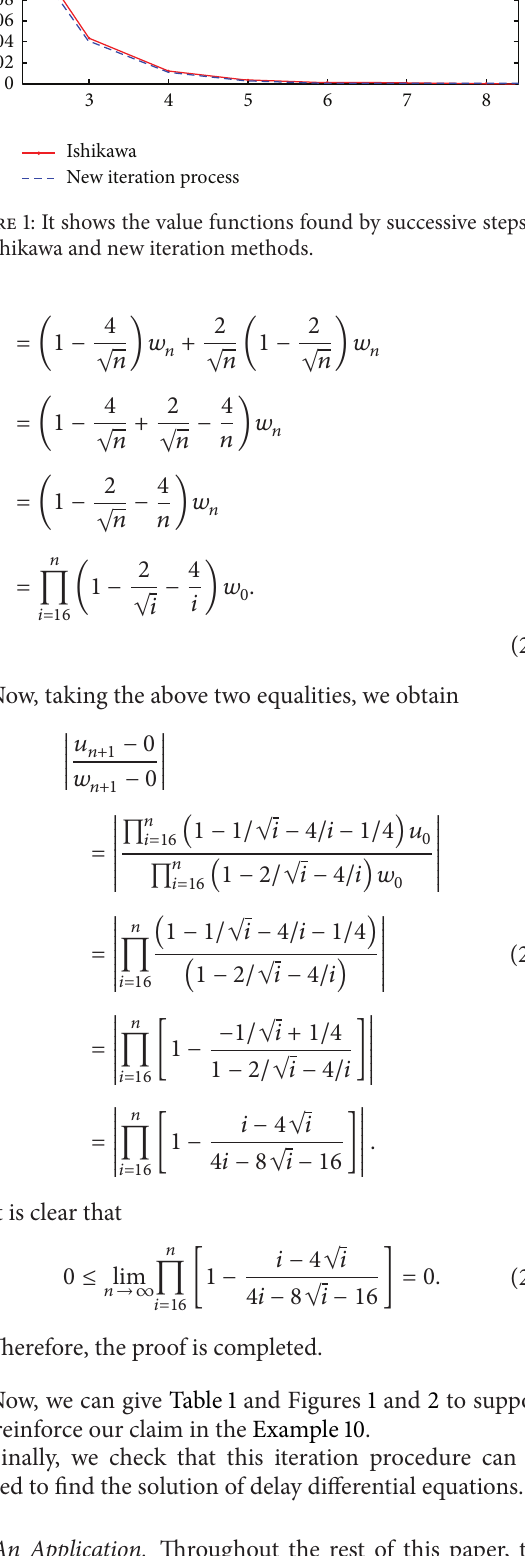
Table 1: Iterative values of the rate of convergence to zero of the Ishikawa and new iteration